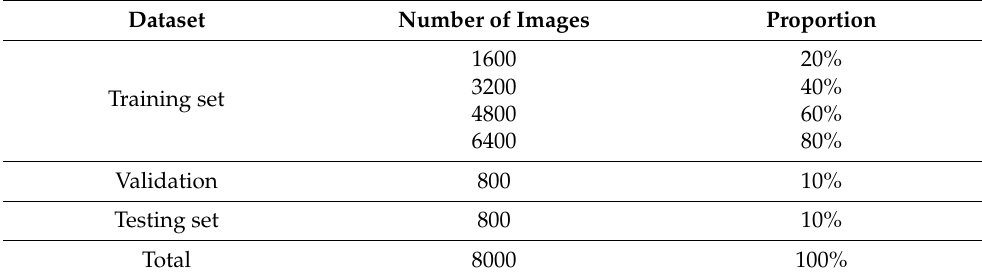
Table 1. Information about the datasets used for training, validation, and testing.